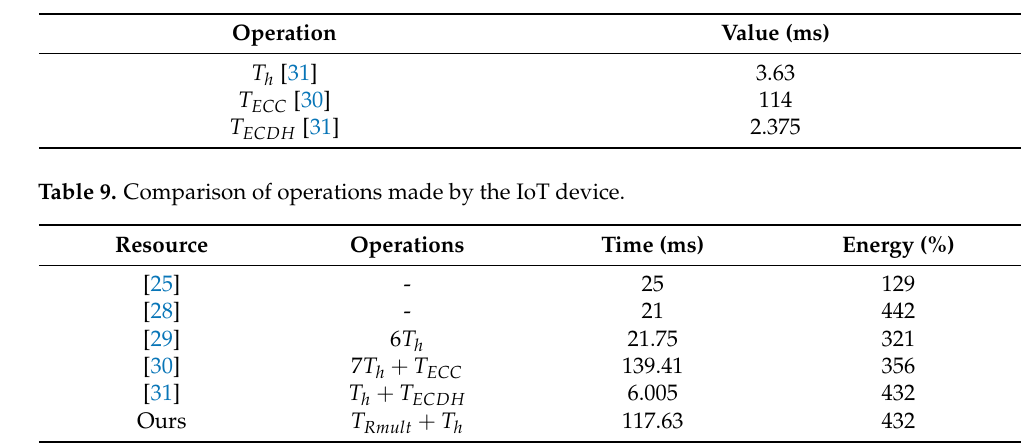
Table 8. The time required for operations on points of an elliptic curve according to [31] on the MICAz sensor.